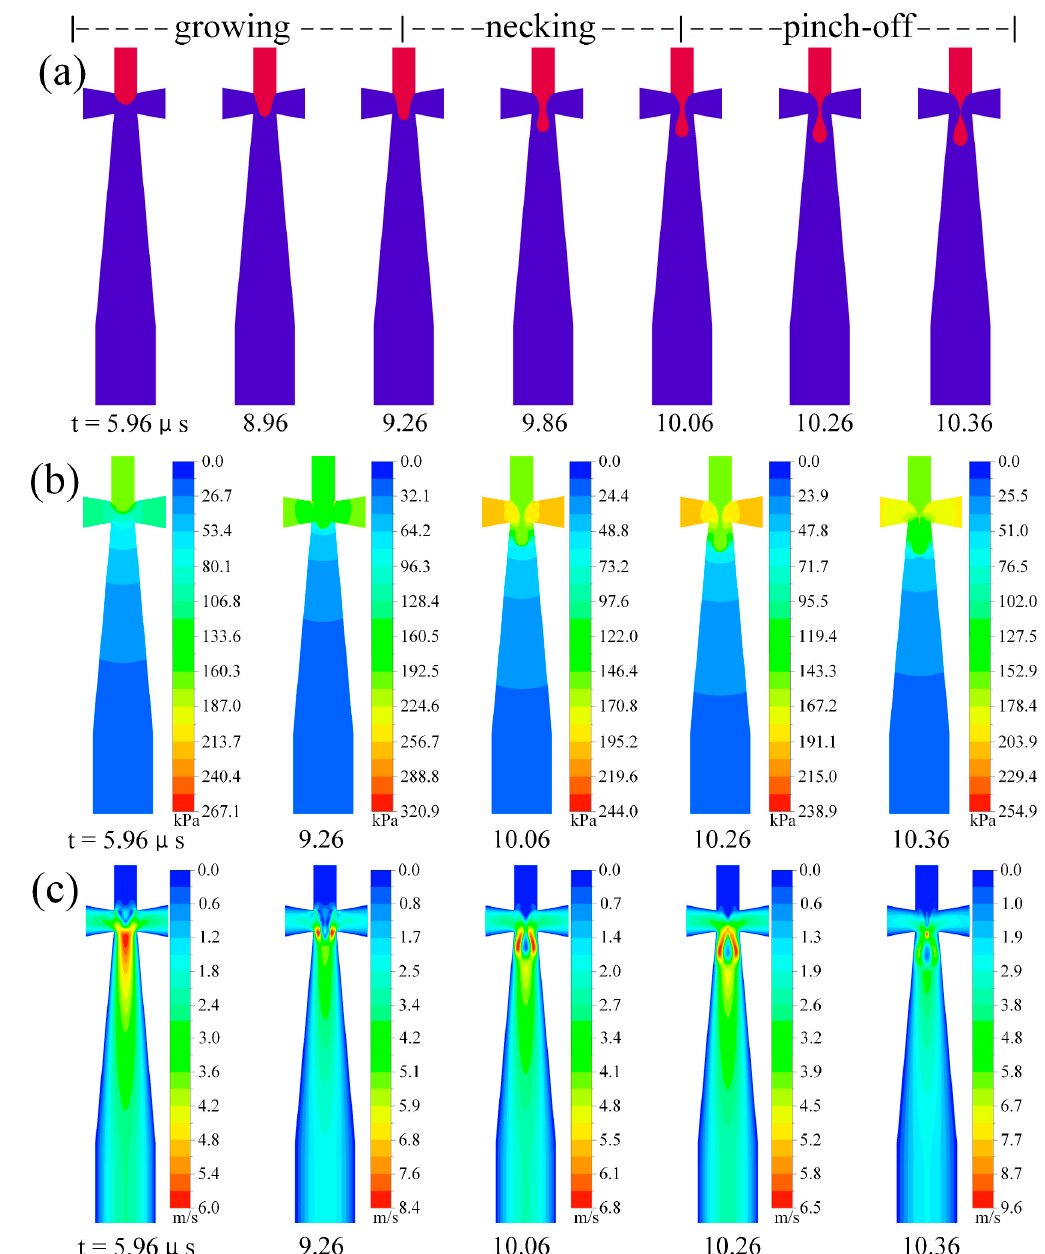
Figure 9. Time evolution of hydrodynamic information during microbubble generation in improved microchannel (Ca = 0.0139, U d = 0.2 m/s): ( a ) evolution of the interface, ( b ) evolution of pressure field, and ( c ) evolution of velocity field.